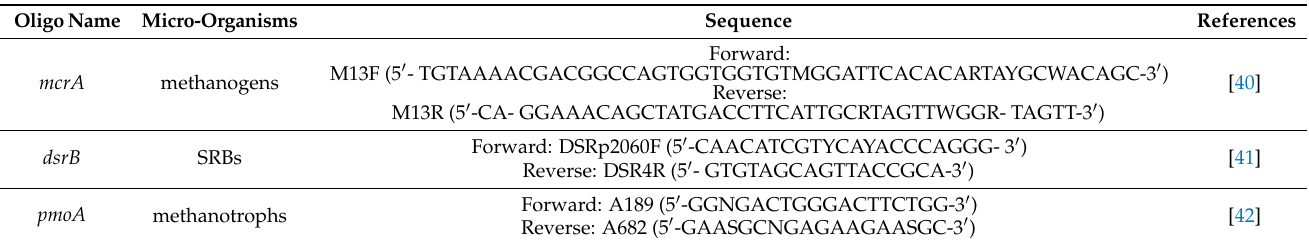
Table 1. Primers used for